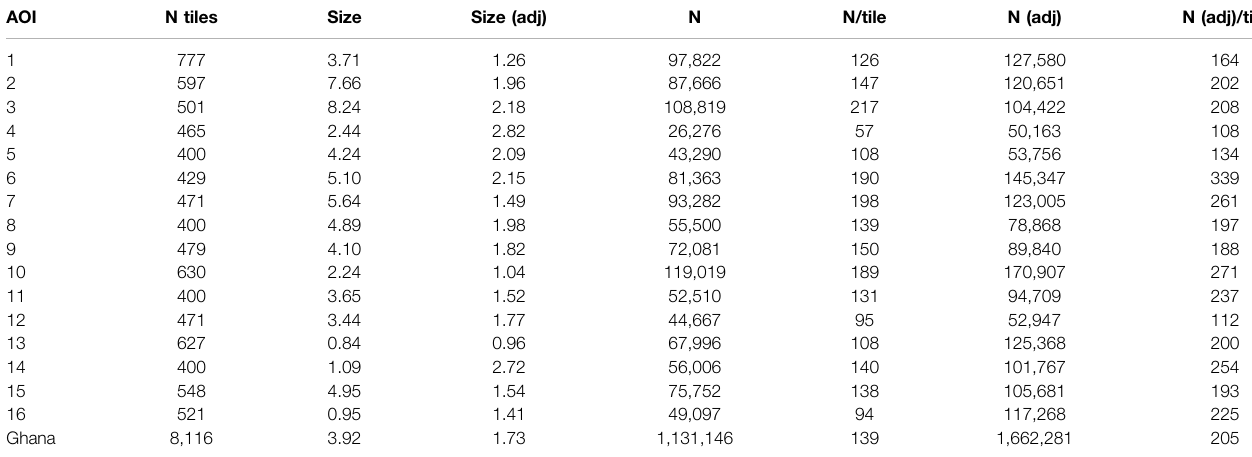
TABLE 3 | The average sizeand total number of crop fi elds for each AOI and for Ghana overall. The originaland bias-adjusted values for each measure are provided, as well as the total number of 0.05 ° degree tiles in each AOI.